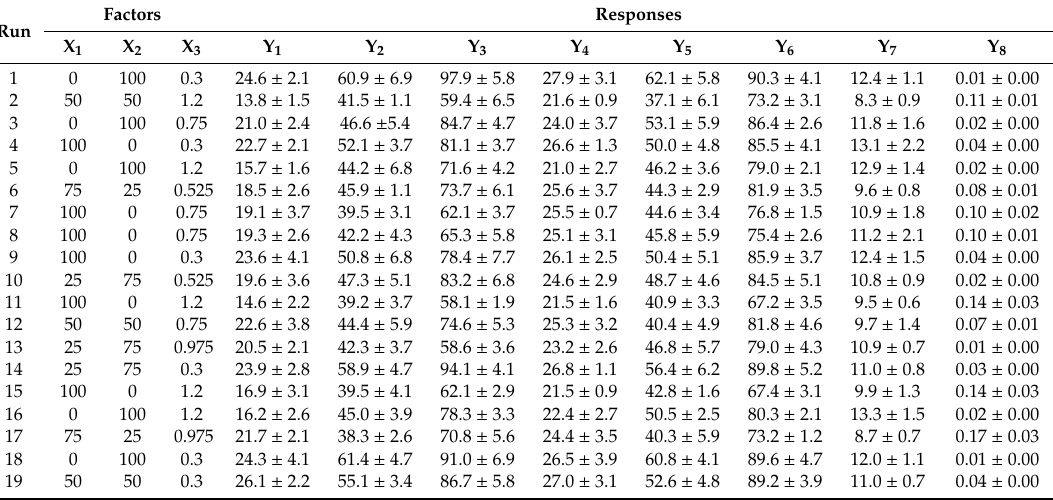
Table 5. Experimental composition and observed responses through combined design.